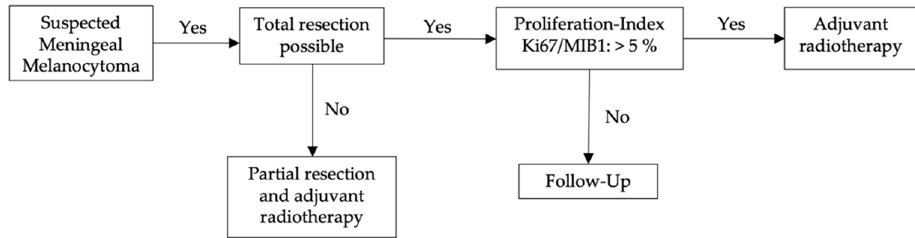
Figure 4. Treatment strategies at initial therapy: When MM is diagnosed, total resection should be the primary goal. Depending on the Ki–67 index, it should then be evaluated whether adjuvant radiotherapy is necessary.